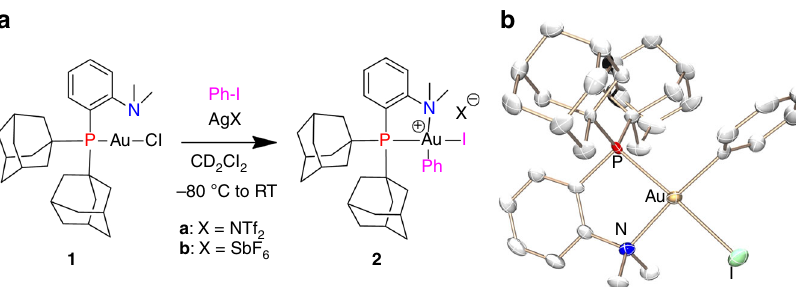
Fig. 2 Generation of the Me-Dalphos gold(III) phenyl complex 2 . a Oxidative addition of iodobenzene to complex 1 . b Molecular structure of complex 2 , hydrogen atoms and the NTf 2 counter-anion are omitted for clarity, selected bond lengths (Å) and angles (°): Au – N 2.214(5), Au – P 2.369(2), Au – C 2.064 (6), Au – I 2.632(1) and P – Au – N: 84.62(13)